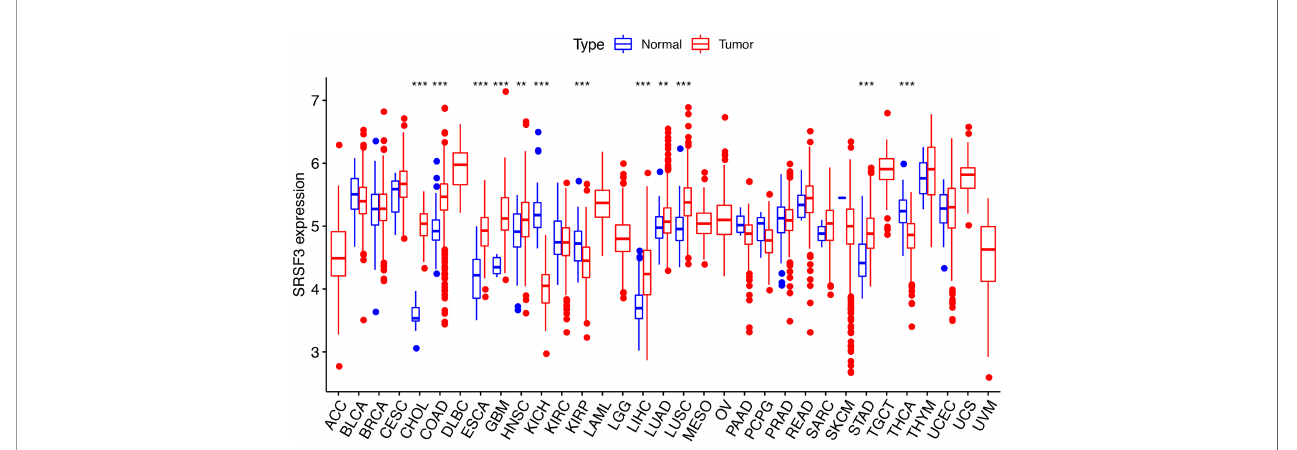
FIGURE 1 | SRSF3 expression in cancers. Human SRSF3 expression level in 33 human pan-cancers from the TCGA database. * P < 0.05, ** P < 0.01, *** P <